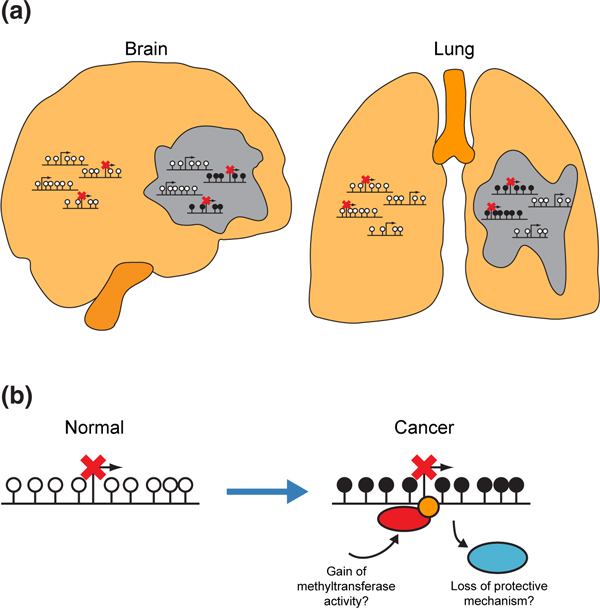
Model: Variation in tumor hypermethylation profiles reflects gene expression in normal tissue. (a) Genes repressed in a tissue-specific manner are prone to hypermethylation in tumors derived from that tissue. (b) Possible mechanisms that result in the hypermethylation of repressed CGI promoters in cancer. CGI promoter hypermethylation could result from either the loss of a mechanism maintaining CGIs in a hypomethylated state (for example,TET enzymes) or a gain of de novo methyltransferase activity at the CGI (whether targeted by transcription factors or through an increase in levels of the proteins in the cell). CGI, CpG island.